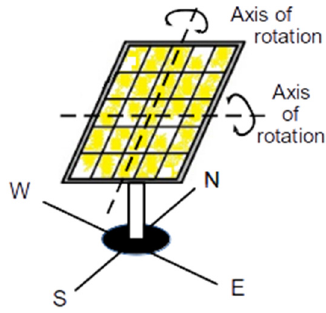
Figure 1. Solar panel with a dual-axis tracker.